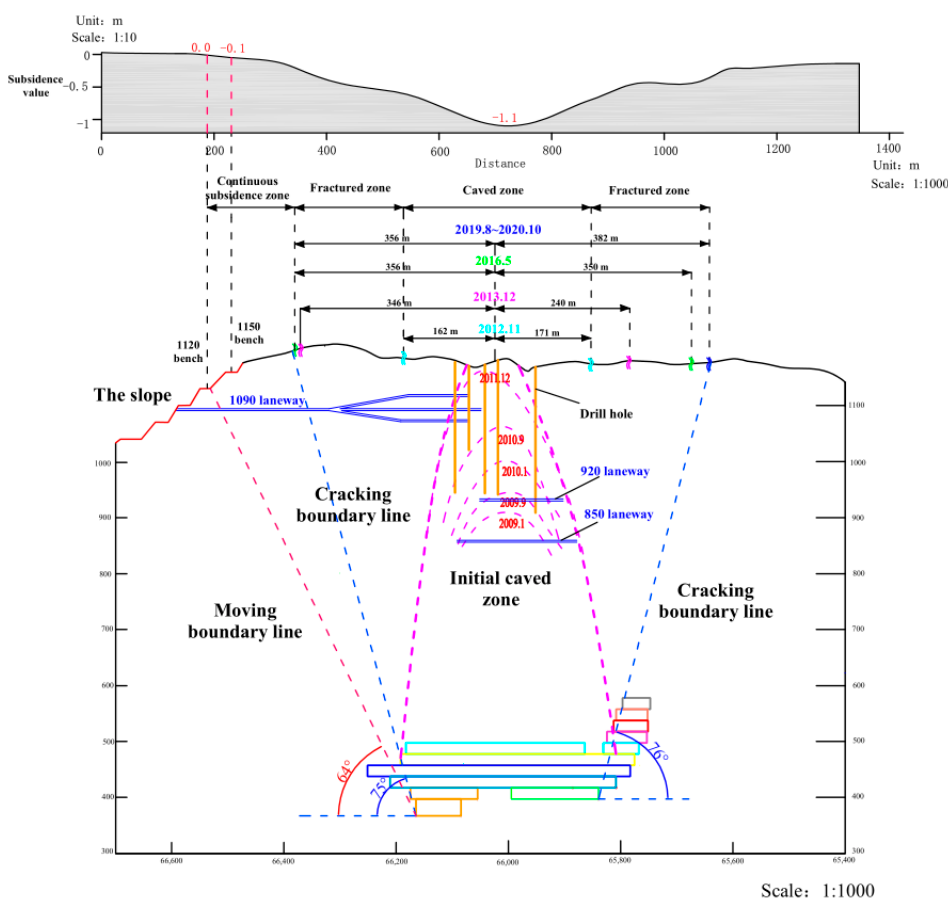
Figure 10. The surface cracking range over the years and the cumulative surface subsidence distribution in 2021 on the A38 pro fi le.